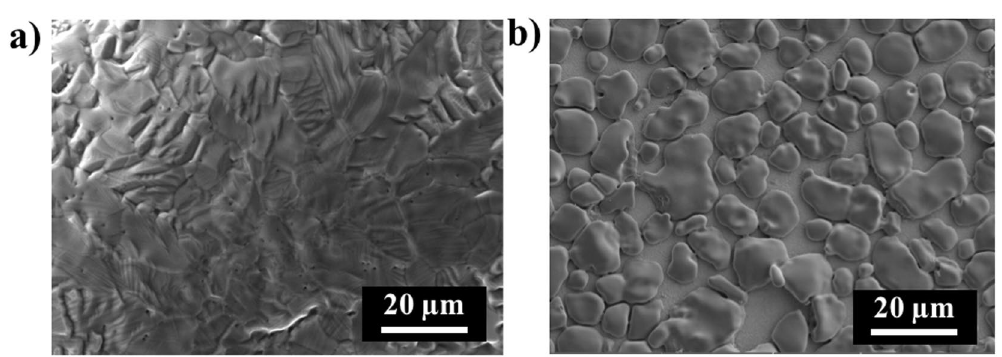
Figure 5. Surface micrographs of the triple-layer films after annealing at ( a ) 1073 K, 6 hours illustrating surface textures representative of incomplete homogenization and ( b ) 1273 K, 6 hours illustrating surface textures of significant mass